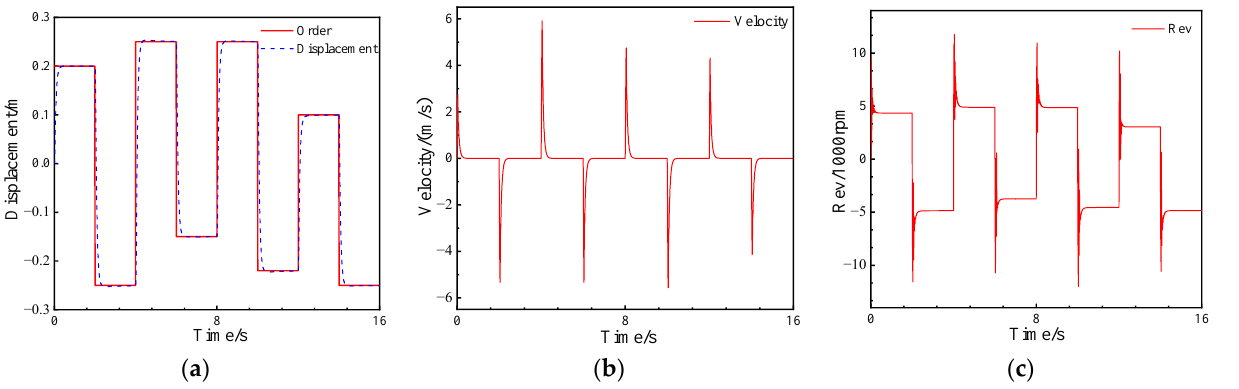
Figure 11. System response under normal circumstances: ( a ) actuator cylinder displacement response; ( b ) actuator cylinder velocity response; ( c ) rotation speed.